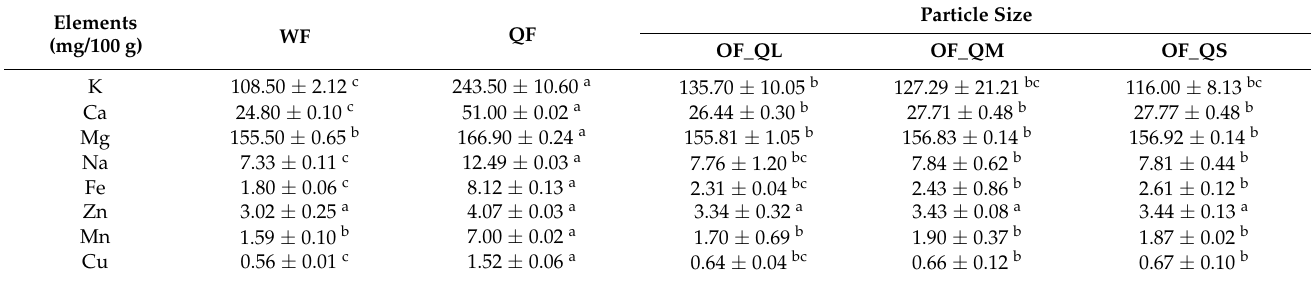
Table 1. The mineral content of the optimal wheat–quinoa composite flour corresponding to large, medium, and small size particles sizes of quinoa flour versus wheat flour.